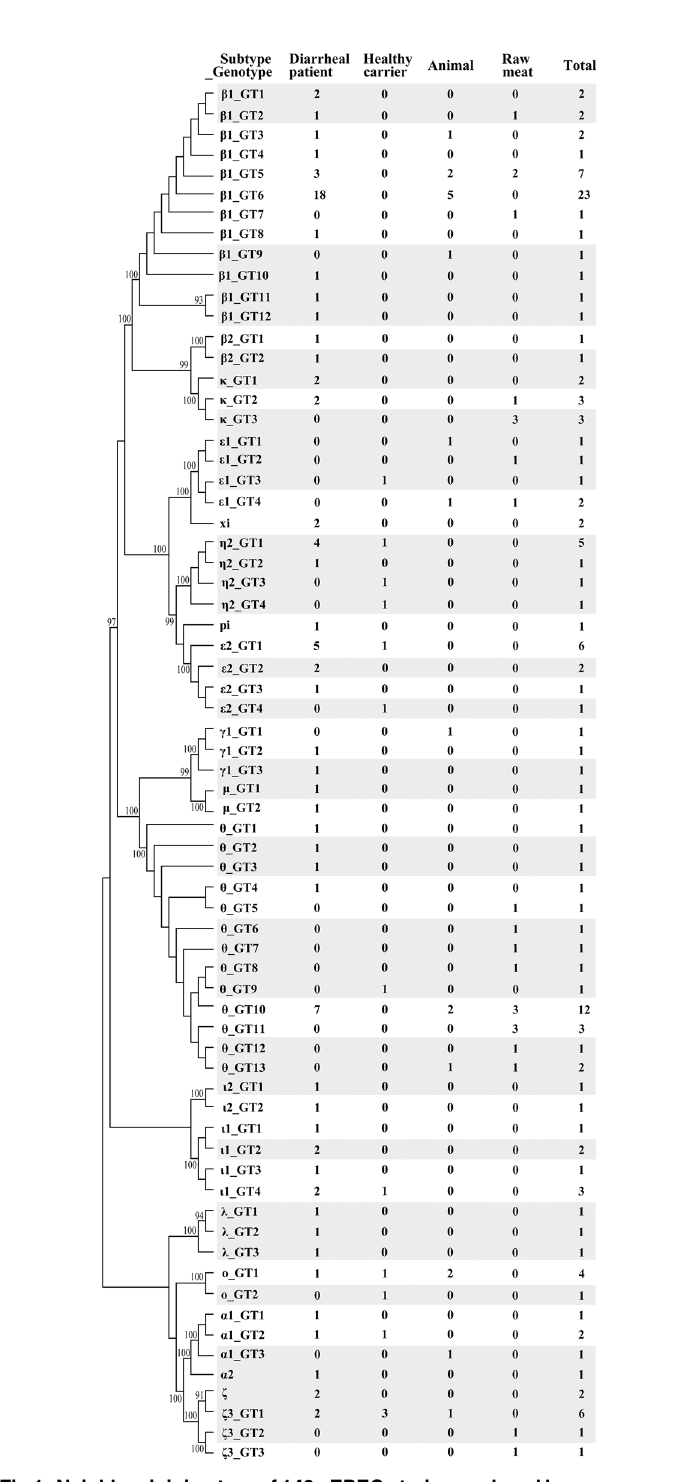
Fig 1. Neighbor-joining tree of 143 aEPEC strains analyzed by eae genes. The corresponding subtypes, genotypes (abbreviated as GT), and number of strains isolated from different sources are listed. The sequences of 39 eae genotypes firstly identified in this study were